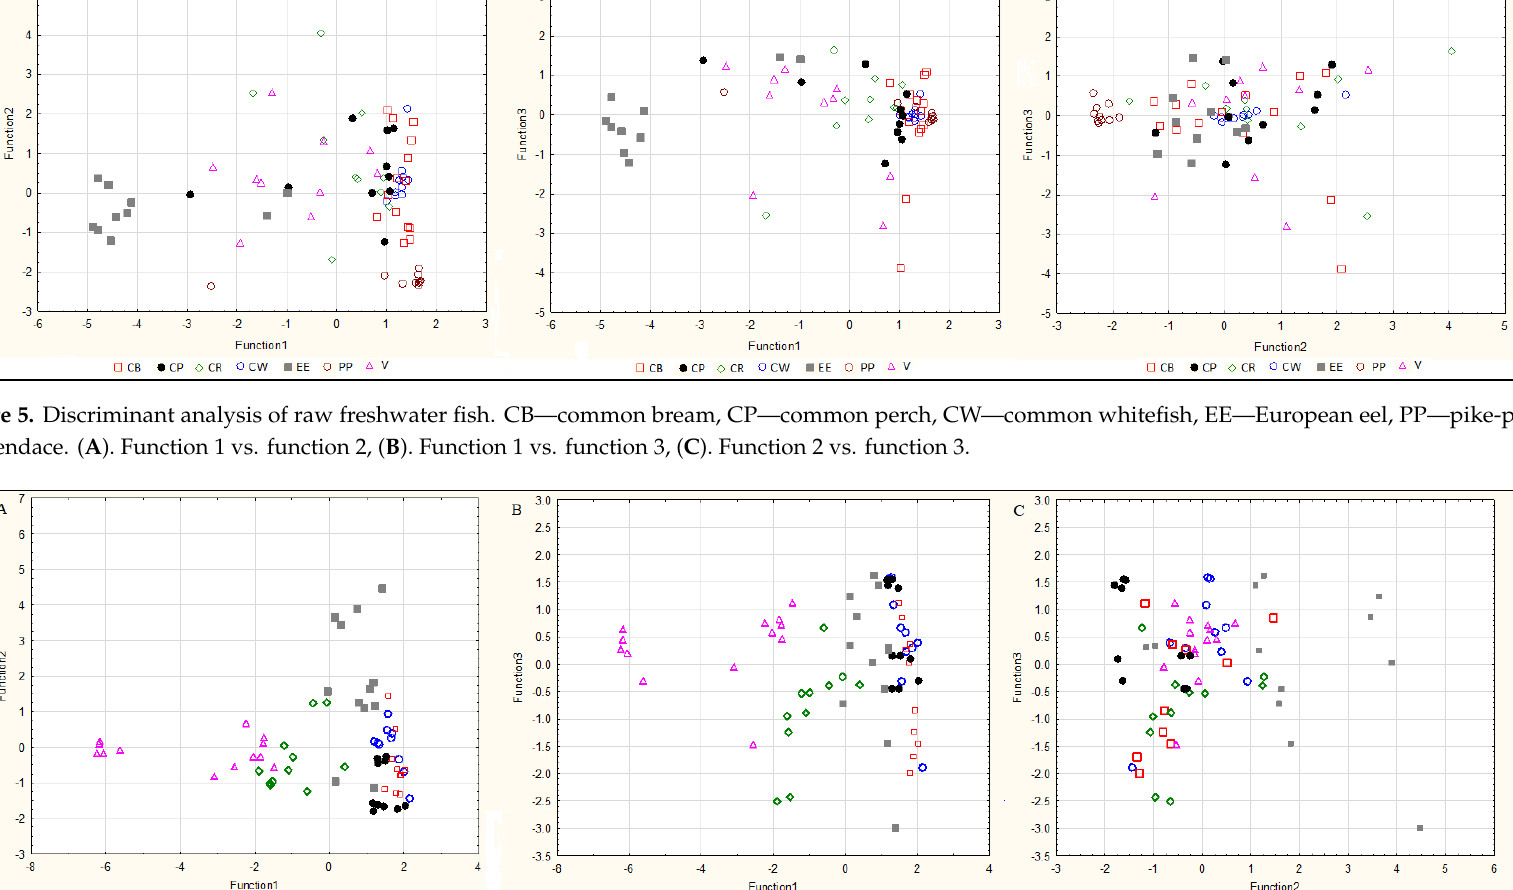
Figure 6. Discriminant analysis of smoked freshwater fish. BT—brown trout, CB—common bream, CP—common perch, CW—common whitefish, EE—European eel, V—vendace. ( A ). Function 1 vs. function 2, ( B ). Function 1 vs. function 3, ( C ). Function 2 vs. function 3.